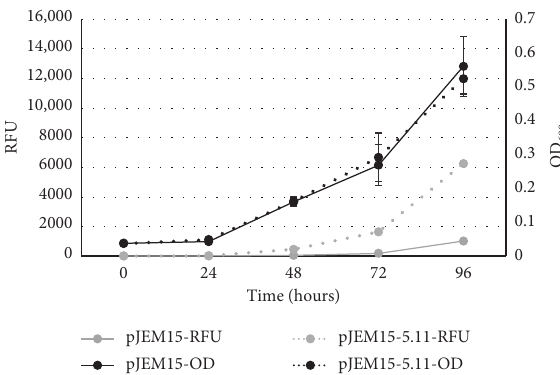
Figure 3: Promoter activity of the putative mfp EA operon. Curves labelled OD represent mycobacterial growth while the RFU curves indicate beta-galactosidase